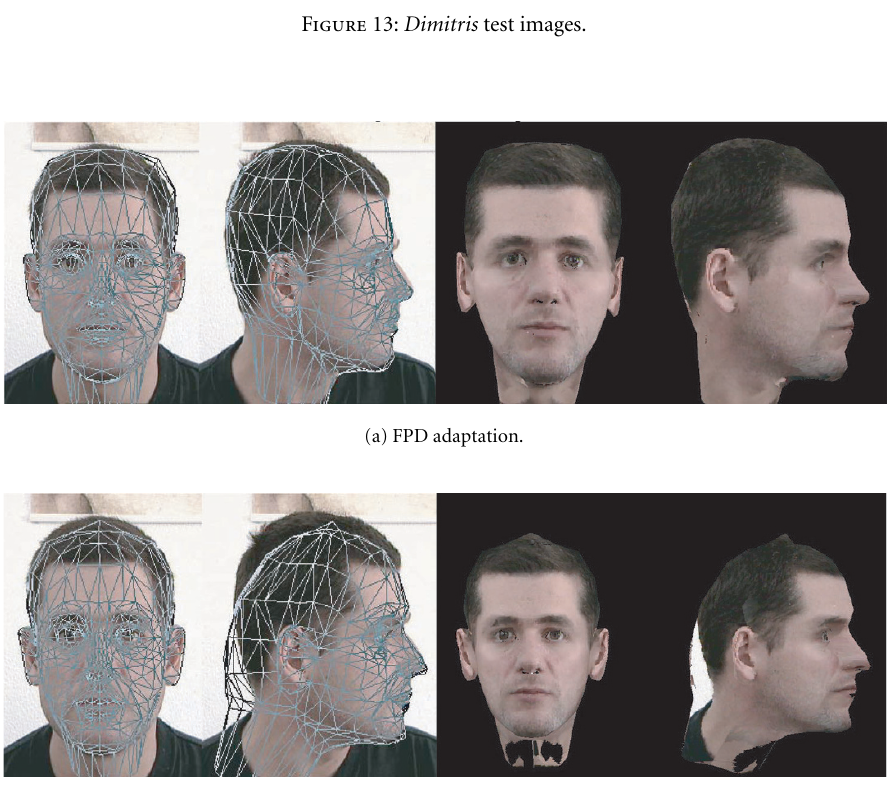
Figure 14: Ngramm test